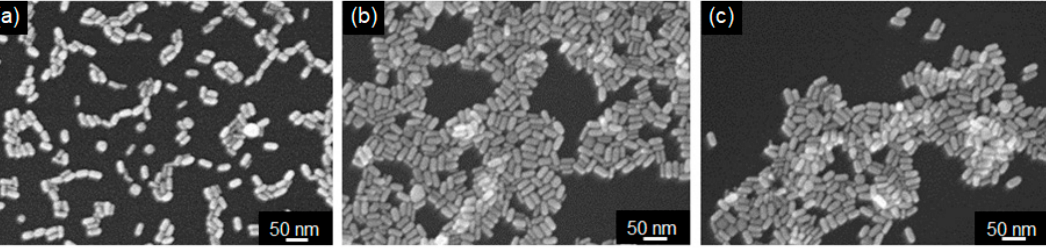
Figure 4. SEM images of Au NRs modified with ( a ) AUT, ( b ) MUA, ( c ) and TEG in 1 mM free CTAB.